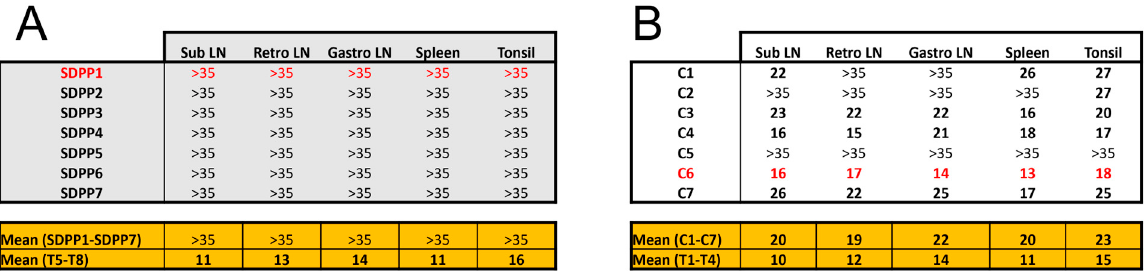
Figure 4. Ct values obtained by qPCR from different tissue samples of individual animals at the end of post-Georgia 2007/01 exposure (d20pe). Data from pigs ( A ) fed the SDPP diet (SDPP1-7 pigs) or ( B ) the conventional diet (C1–C7 pigs). The higher the Ct values, the lower the ASFV load, with Ct values > 35 being considered negative (cut-off of the technique). Tables in orange show the average Ct values obtained in samples from Trojan pigs. Animals in red color died before the end of the experiment. Abbreviations: Sub LN = Submaxillary lymph nodes; Retro LN = Retropharyngeal lymph nodes; Gastro LN = Gastro-hepatic lymph nodes.